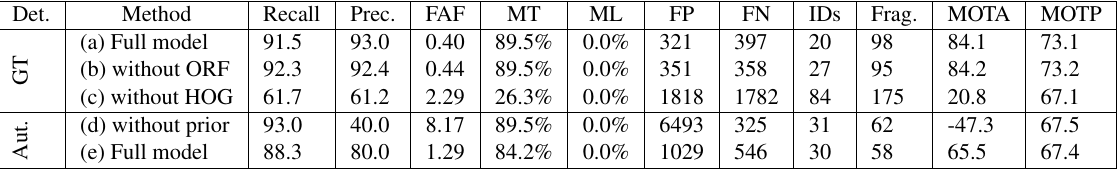
Table 1. Sensitivity study in 2D with ground truth (GT) and automatically generated (Aut.) detections Det.